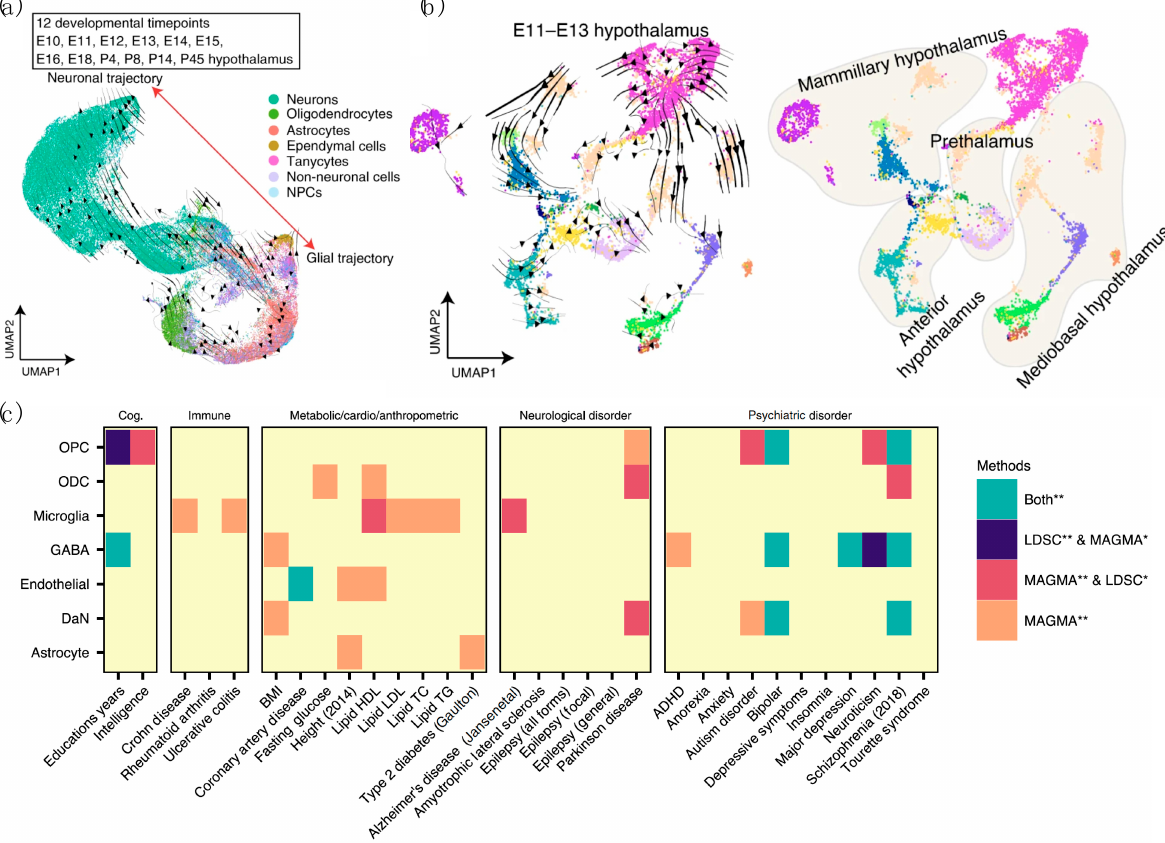
Figure 4. Emerging computational and analytical tools that can be used in sc/snRNA-seq studies of PD. UMAP and RNA velocity trajectories of cells from ( a ) E10–P45 and ( b ) E11–E13 developing diencephalon in mice. Reprinted from [92] , Copyright 2020, Dong Won Kim et al. ( c ) Use of LD Score Regression (LDSC) and Multi-Marker Analysis of Genomic Annotation (MAGMA) to assess the associations between previously reported genetic risk variants of different complex “traits”, or brain-related disorders, and SN cell types. Reprinted from [30] , Copyright 2020, Devika Agarwal et al. Color of heatmap indicates degrees of statistical significance. *: p value (<0.05), **: Bonferroni corrected q value, Cog.: cognitive phenotypes, Immune: autoimmune diseases, Metabolic/Cardio/Anthropometric: metabolic, cardiovascular and anthropometric traits.